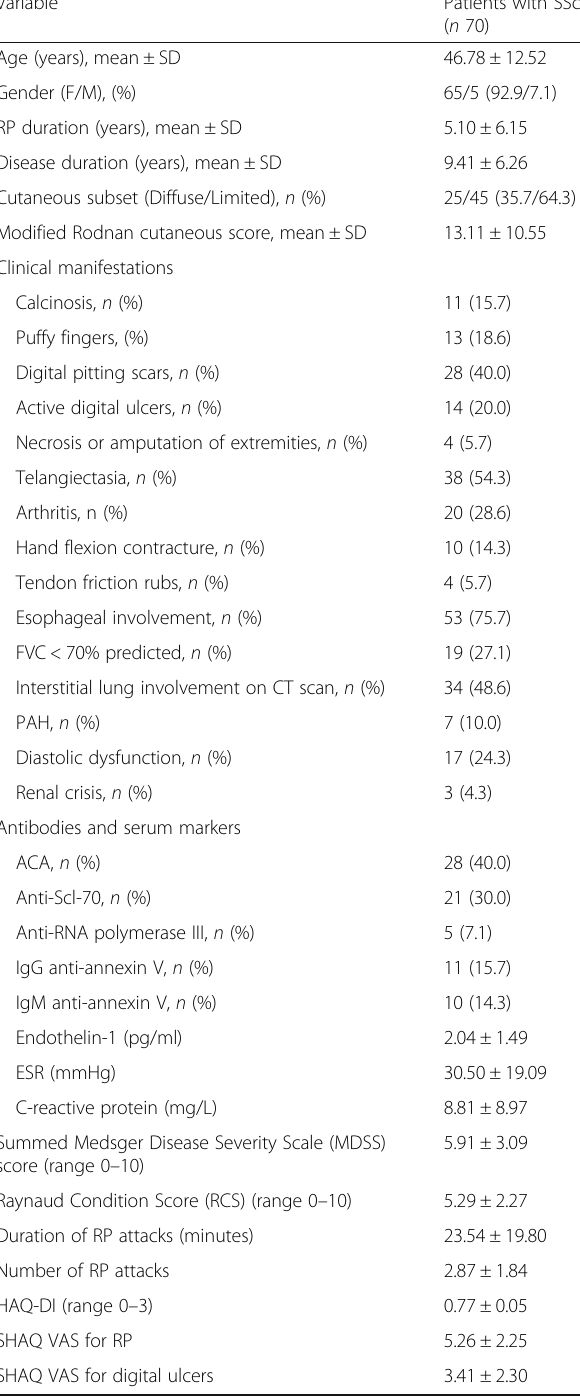
Table 1 Demographic and clinical features of the SSc